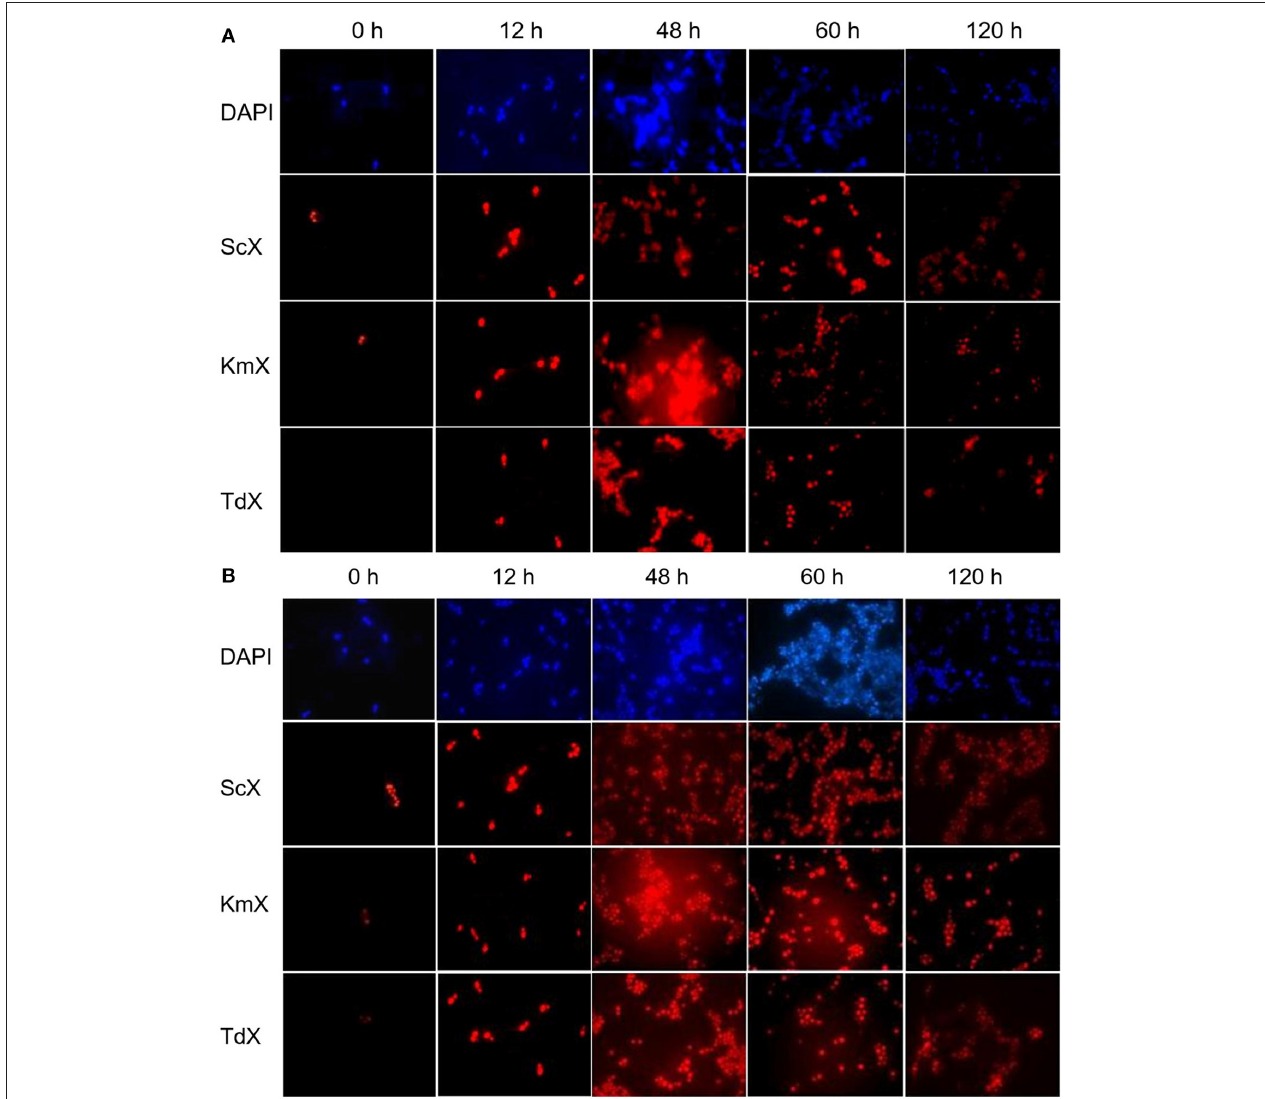
FIGURE 1 | Qualitative examples of FISH images obtained during fermentation of Agave medium using specific probes for Saccharomyces cerevisiae (Sc3Y3), Torulaspora delbrueckii (Td1AN9), and Kluyveromyces marxianus (Km1Y9) strains at inoculation ratios of (A) 0.1:1:1, and (B) 1.1:1, respectively. Fluorescent detection was carried out using an Olympus Microscope (Olympus BX51) at 100 ×